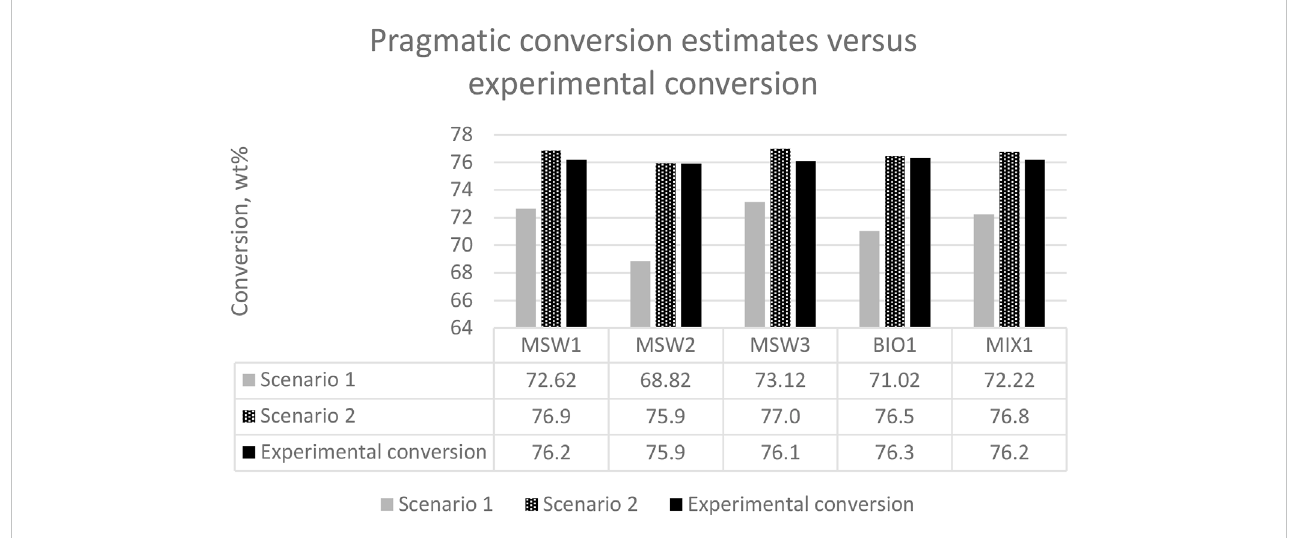
FIGURE 4 Pragmatic conversion estimates using two scenarios compared to observed experimental